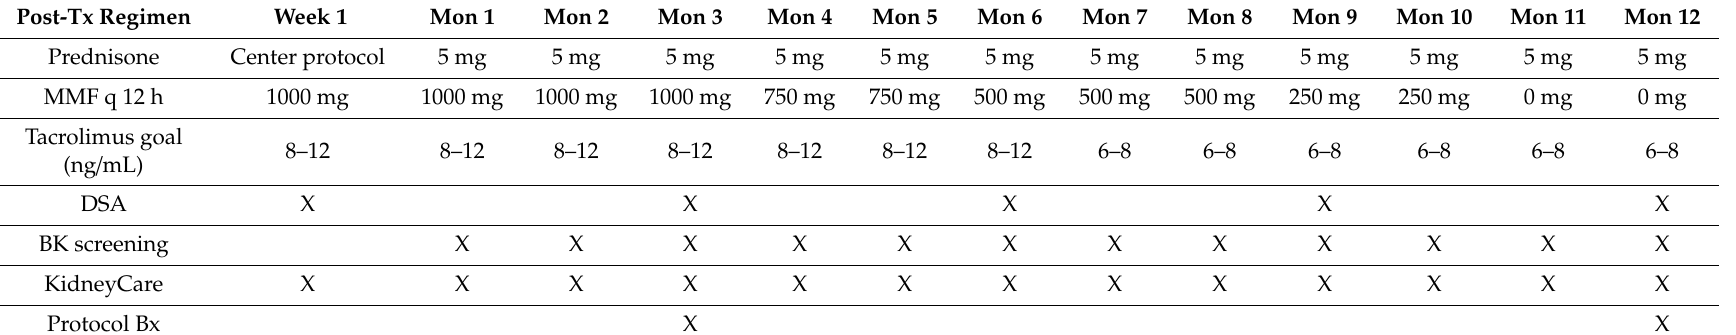
Table 1. Unblinded, two-armed interventional trial–MMF minimization arm, first year post transplant.